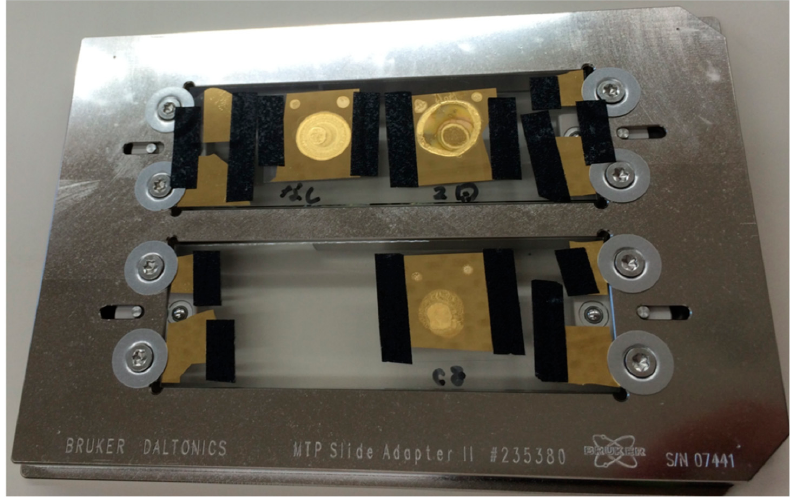
Figure 2. Samples (protein / SAM / Au / Ge / glass) fixed on a MALDI target plate after all the processes presented in Figure